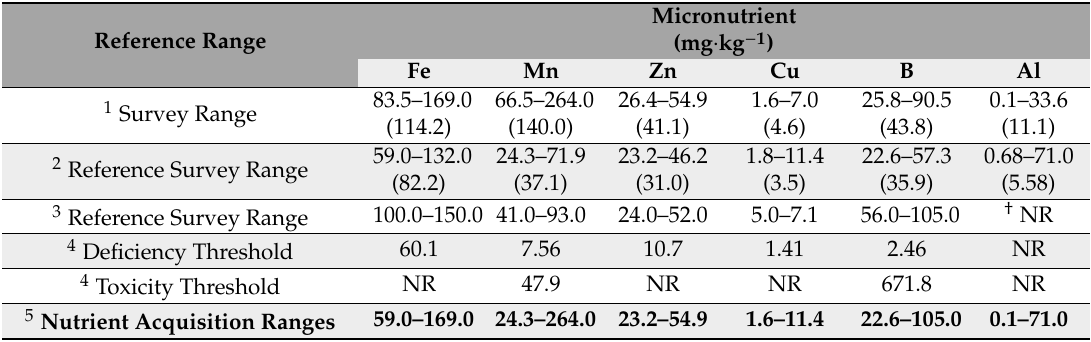
Table 4. Comparison of combined micronutrient concentration ranges and means for the thirteen greenhouse-propagated cannabidiol (CBD) hemp cultivars to reference survey ranges with additional reference to deficiency and toxicity thresholds. Combined survey range values to indicate the minimum and maximum expanded nutrient acquisition ranges among all referenced